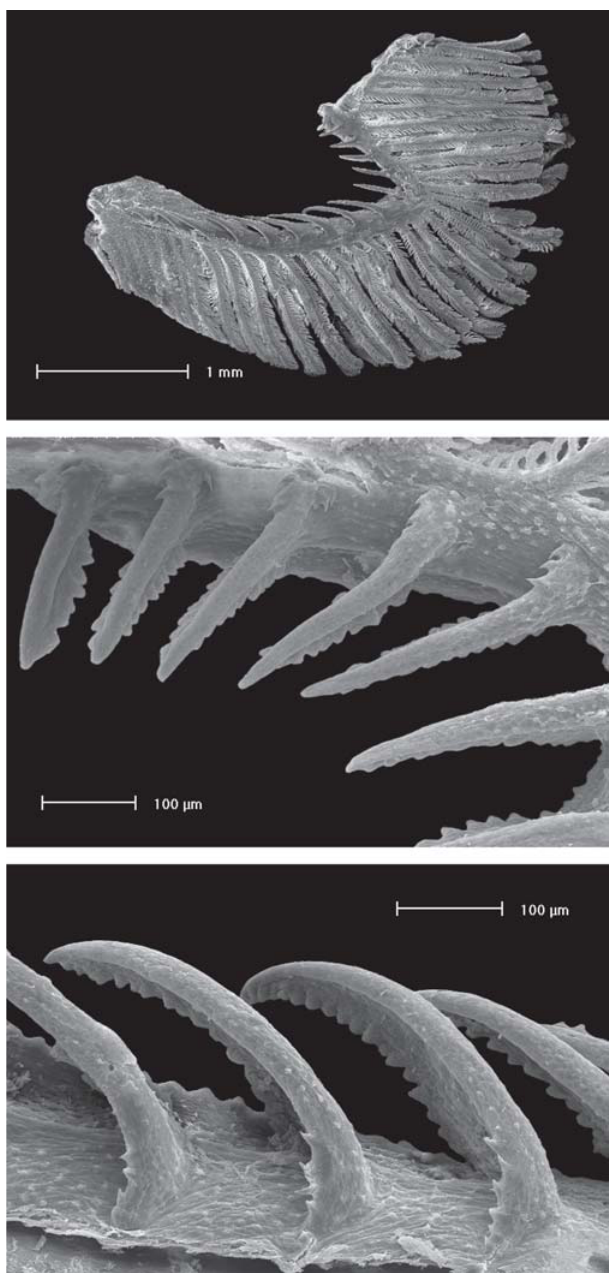
Fig. 7. First gill arch of Odontostilbe pulchra : left side, lateral view, showing gill gland (top) of FMNH 84037, male 26.6 mm SL, in detail gill rakers on upper branchial branch (middle), and gill rakers on lower branchial branch (bottom) of MCP 38863, male 27.2 mm SL. Scanning electron micrographs (SEM).